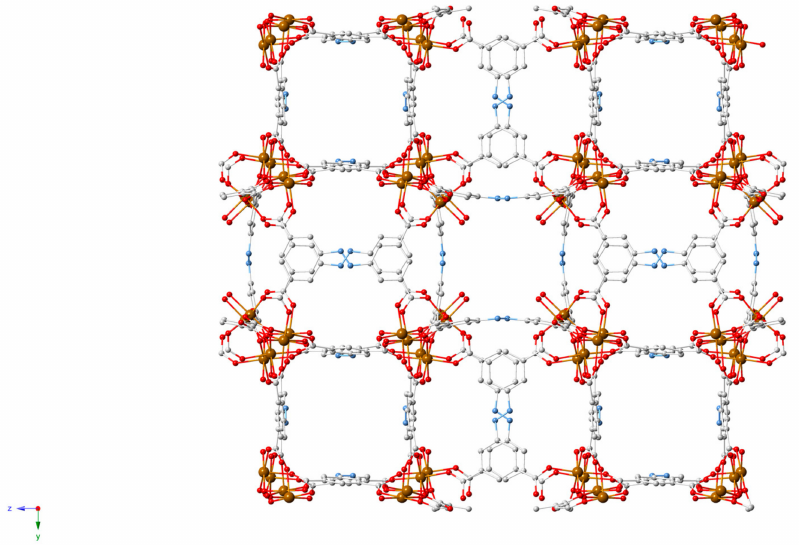
Figure 7. MIL-127 (Fe) crystal structure